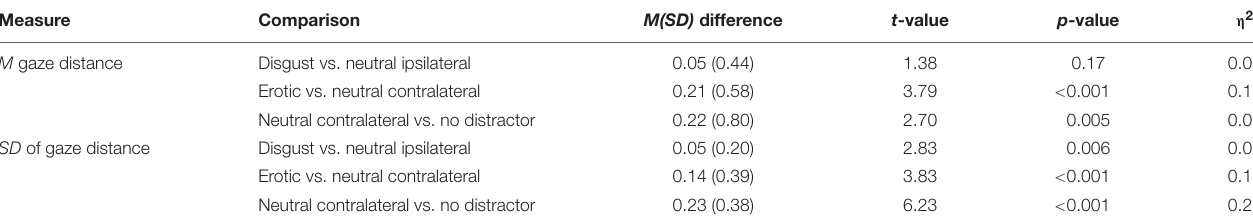
TABLE 2 | Results of within-subject t -tests of the mean gaze distance and the standard deviation of the gaze distance in degree of visual angle. Measure